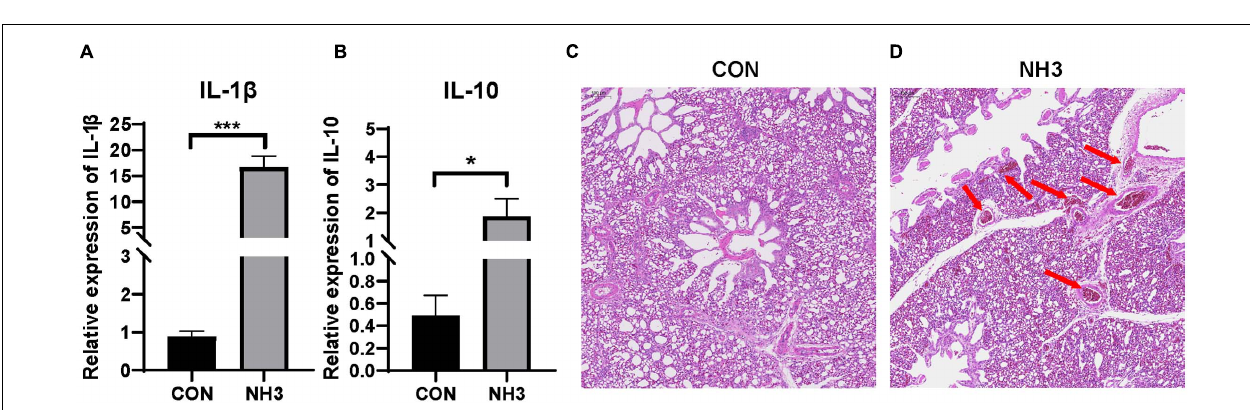
FIGURE 6 | Ammonia exposure caused lung injury. (A) Relative expression of interleukin (IL)-1 β in the control (CON) ( n = 6) and ammonia (NH 3 ) ( n = 6) groups. (B) Relative expression of IL-10 in the CON and NH 3 groups. *** p < 0.001 and * p < 0.05 indicate significant differences between the two groups. (C) Hematoxylin and eosin-stained sections of the CON group. (D) Hematoxylin and eosin-stained sections of the NH 3 exposure group. The arrow in panel (D) indicates local tissue hemorrhage. Scale bar: 100 µ